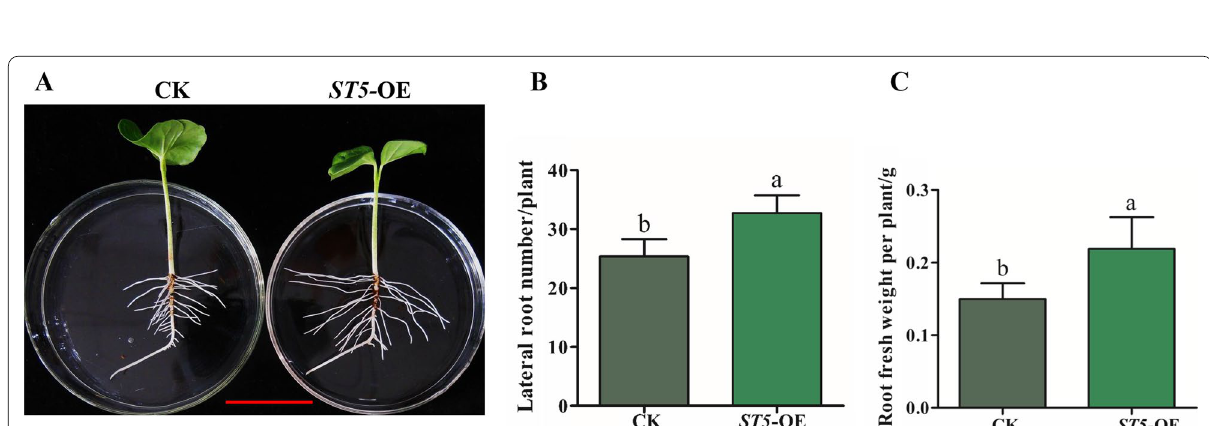
Fig. 2 ThST5 significantly enhanced salt tolerance in transgenic cotton at seedling stage. A , B Growth phenotype of CK and ST5 -OE under saline hydroponic conditions. Four days old seedlings were shifted to hydroponic culture for 7 days and treated with 140 mmol before photographs were captured. Bar 4 cm. C Survival rate of transgenic plants under saline hydroponic culture. Values are mean = three biological replicates (16 seedlings of each genotype per replicate). Different letters represent significant difference ( P < 0.05) as calculated by Duncan’s multiple range tests. D , E Growth phenotype of CK and ST5 -OE in soil. Twenty days-old seedlings were irrigated with either water or 300 mmol L − 1 NaCl for 10 days. Photographs were captured at the 10th day after the treatment. Bar · in saline soil. Values are mean SD of three biological replicates (16 seedlings of each genotype per replicate). Different letters represent significant ± difference ( P < 0.05) as calculated by Duncan’s multiple range tests